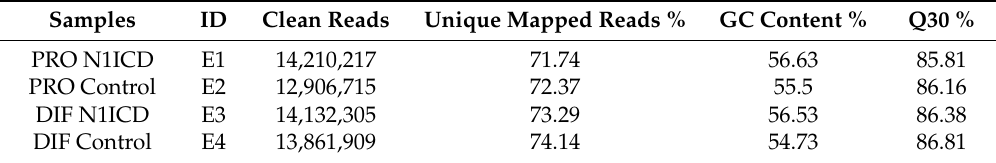
Table 1. Gene expression profile data statistics. PRO, proliferation; DIF, differentiation.